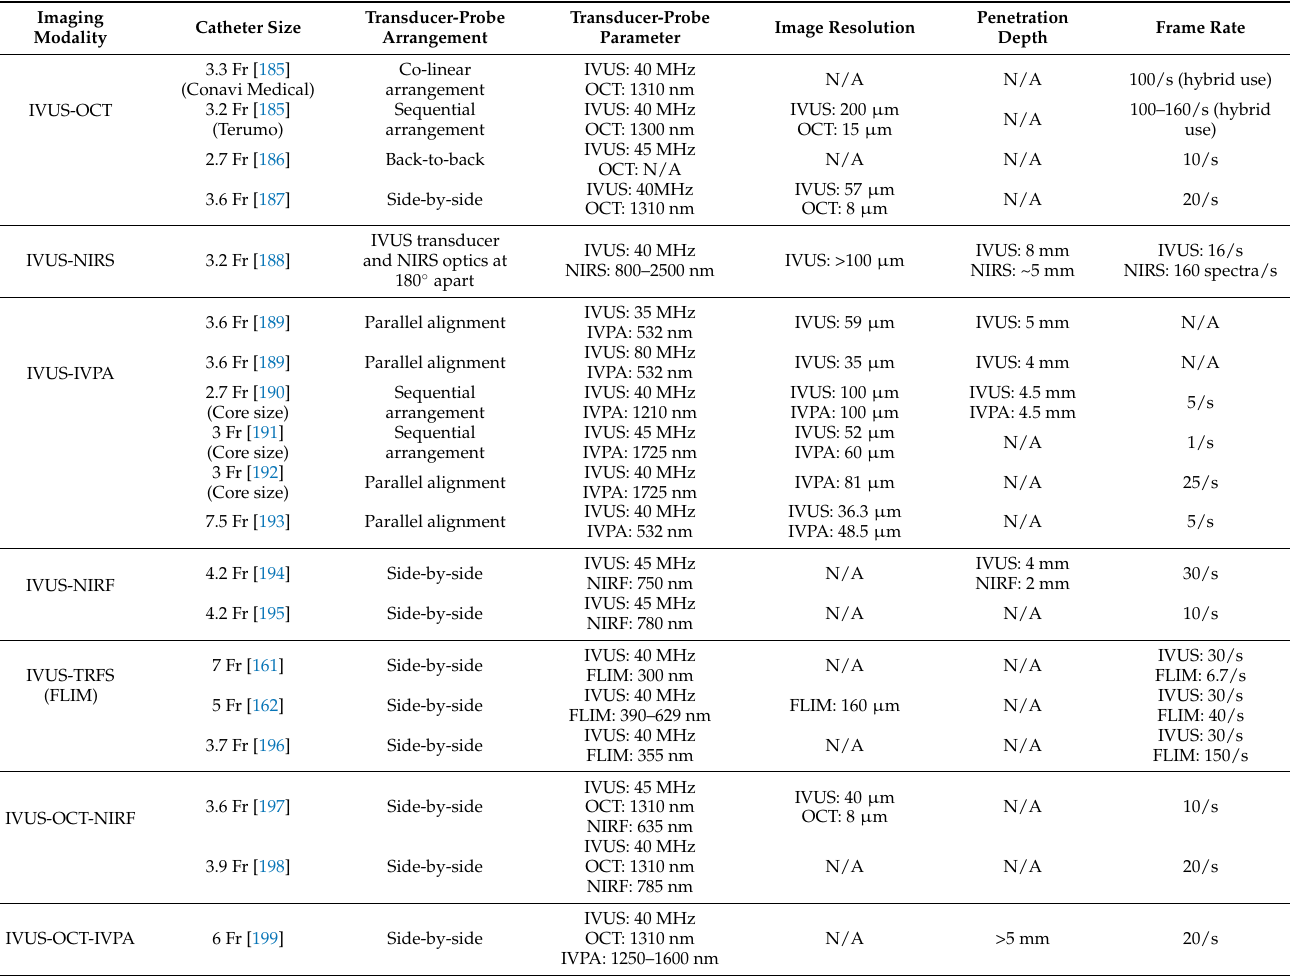
Table 10. A summary of IVUS-based multi-modality intravascular imaging system performance. Imaging